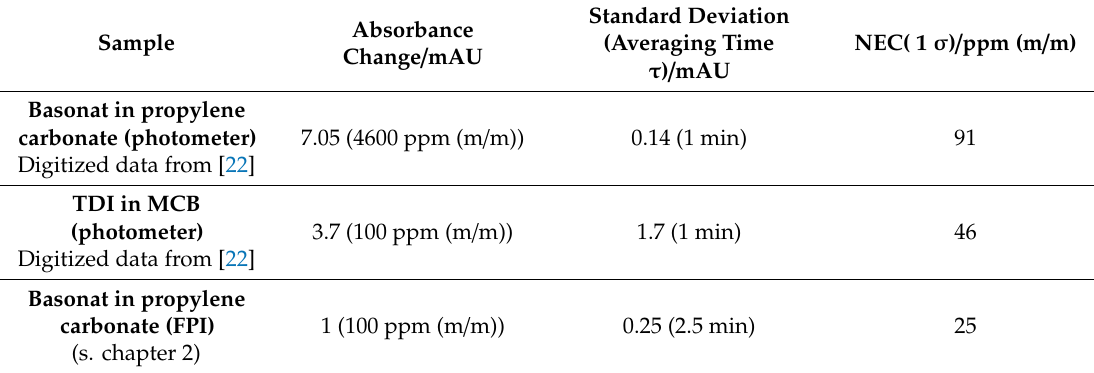
Table 4. Data of ATR transmission experiments with sapphire